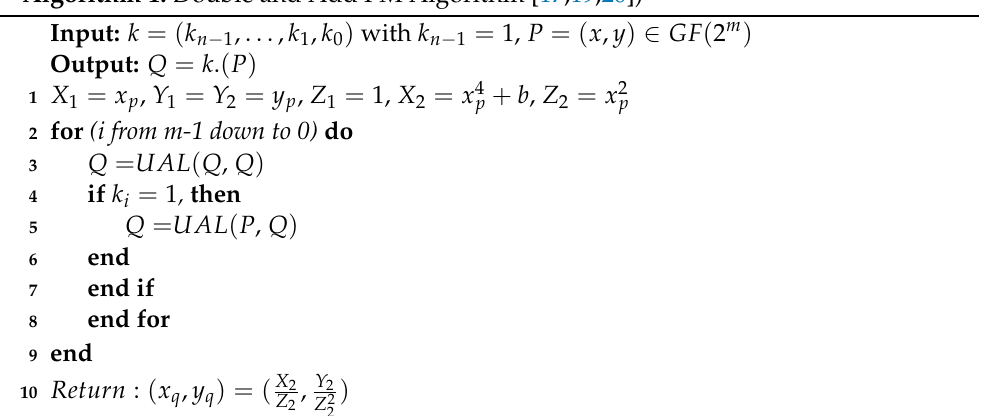
Algorithm 1: Double and Add PM Algorithm